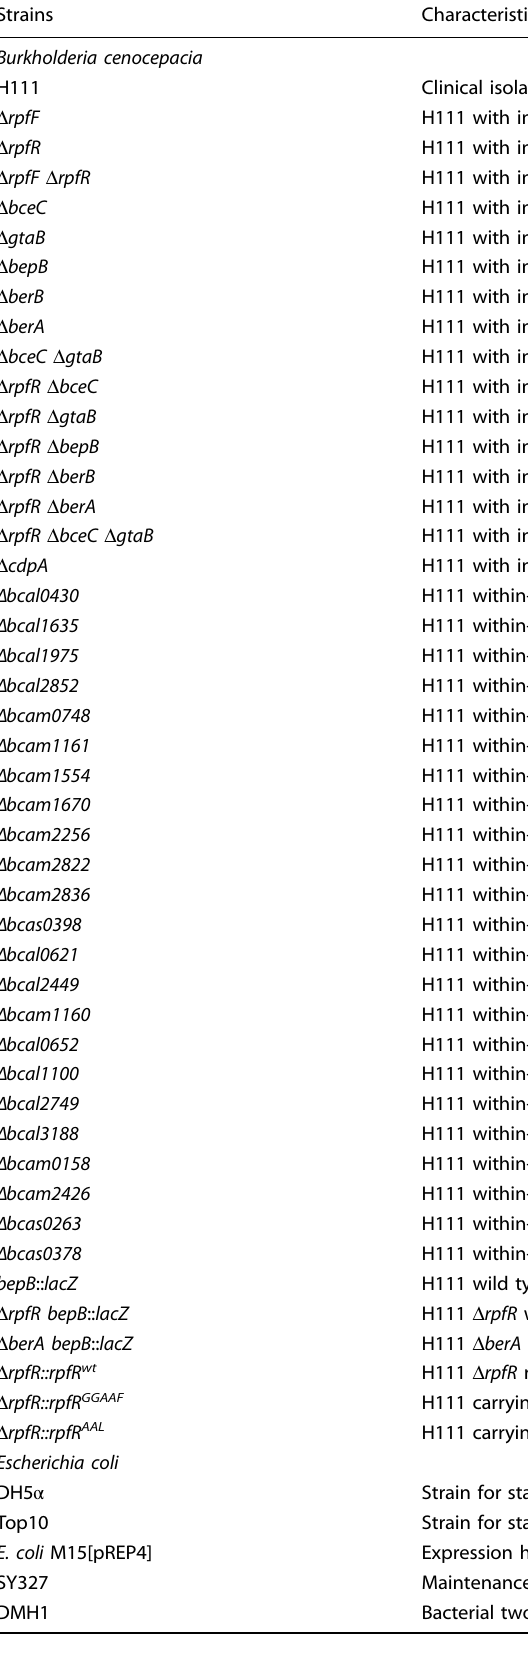
Table 1. Bacterial strains used in this study. Strains